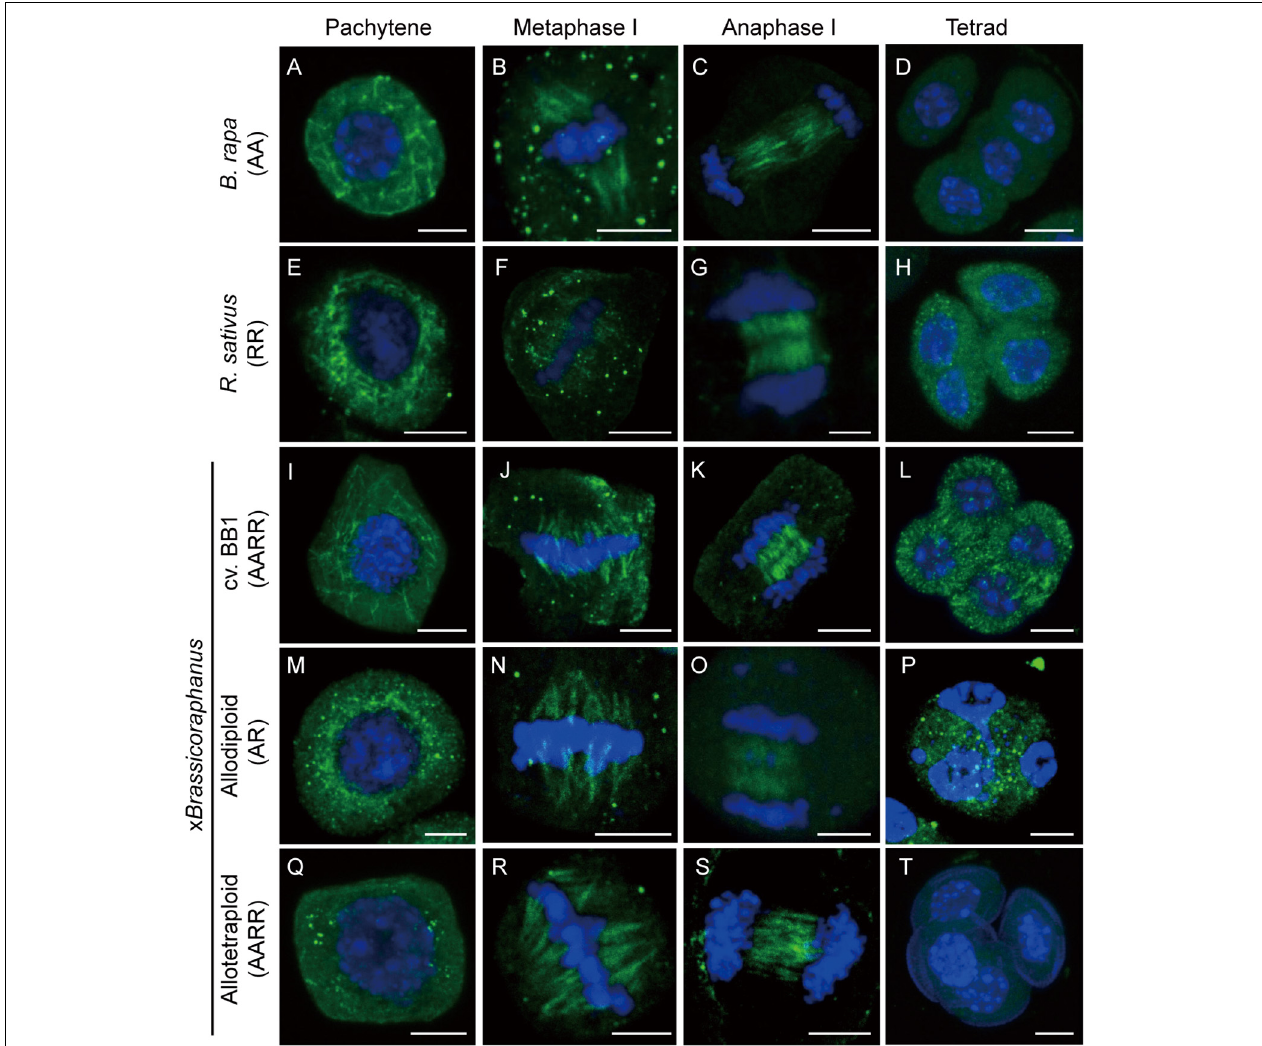
FIGURE 2 | Microtubule distribution during meiosis. Microtubule and chromosome behaviors were observed in PMCs of B. rapa (A–D) , R. sativus (E–H) , BB1 (I–L) , and synthetic allodiploid (M–P) and allotetraploid x Brassicoraphanus (Q–T) . Microtubules appeared throughout the cytoplasm of the PMC at pachytene (A,E,I,M,Q) . Connections between chromosomes and microtubules were displayed at metaphase I (B,F,J,N,R) . Phragmoplast microtubules were located between two daughter nuclei in anaphase I (C,G,K,O,S) , and four separated daughter nuclei were observed at tetrad (D,H,L,P,T) . Microtubules and chromosomes were in green and blue, respectively. Scale bars = 5 µ